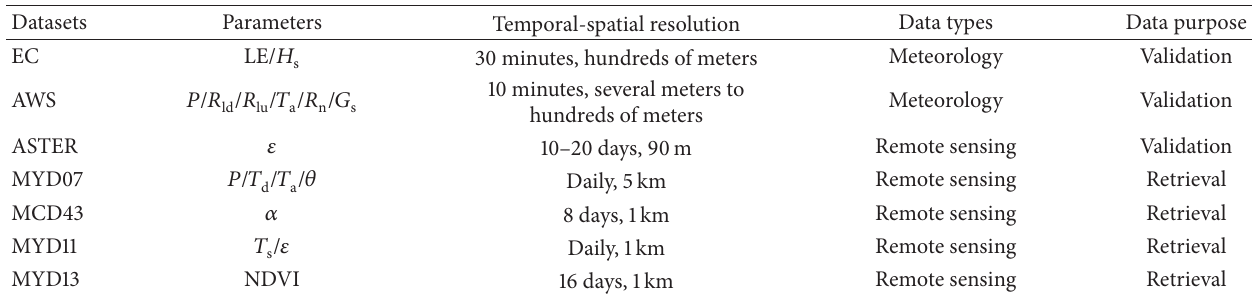
Table 2: Datasets for